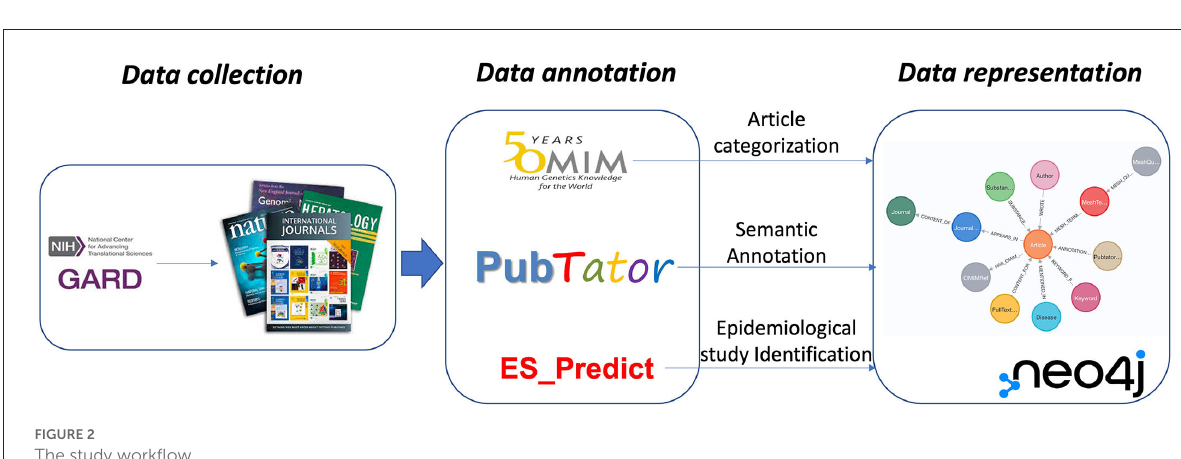
FIGURE2 The study